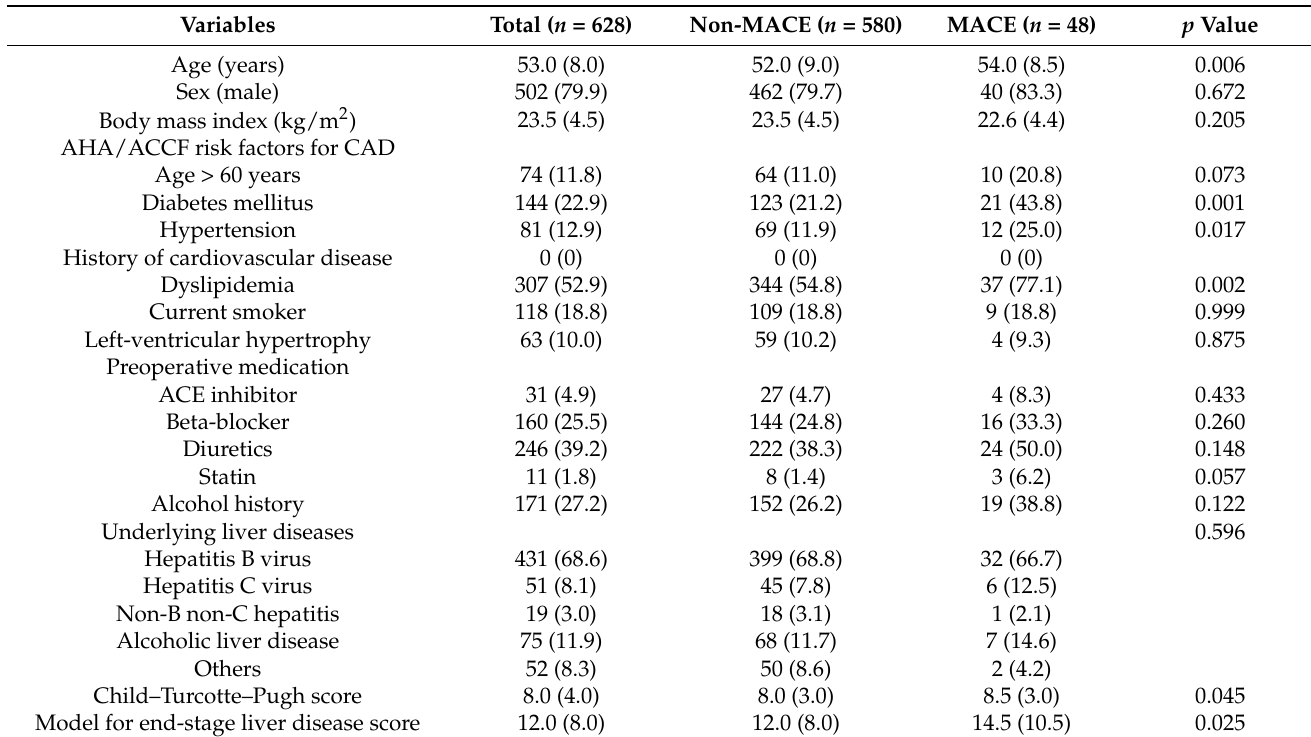
Table 1. Clinical characteristics of liver transplant recipients according to the major adverse cardiac events that developed.